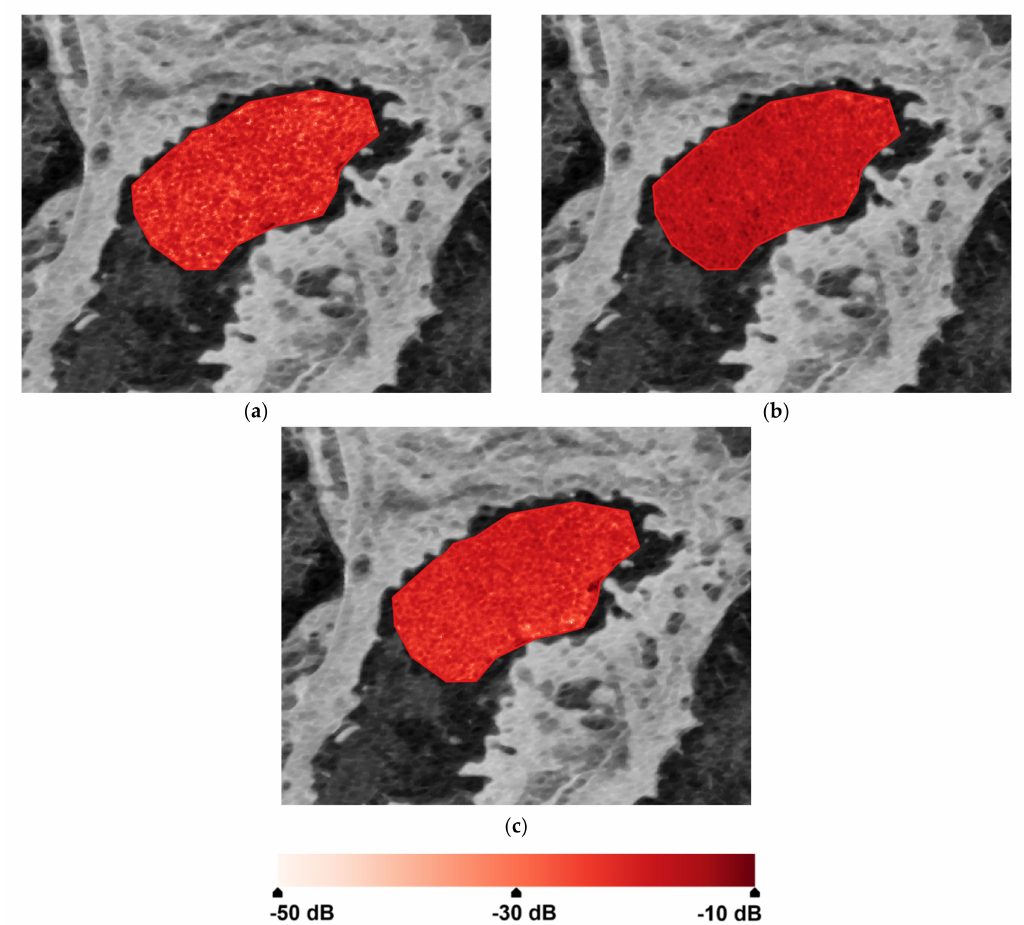
Figure 6. Evolution of the surface backscattering in FX on ( a ) 27 September (estimated ice thickness = 14.3 cm), ( b ) 10 October (estimated ice thickness = 29.6 cm), and ( c ) 25 December (estimated ice thickness = 122.1 cm) within the selected sample polygon. Background is the total backscattering power (SPAN) of 23 September